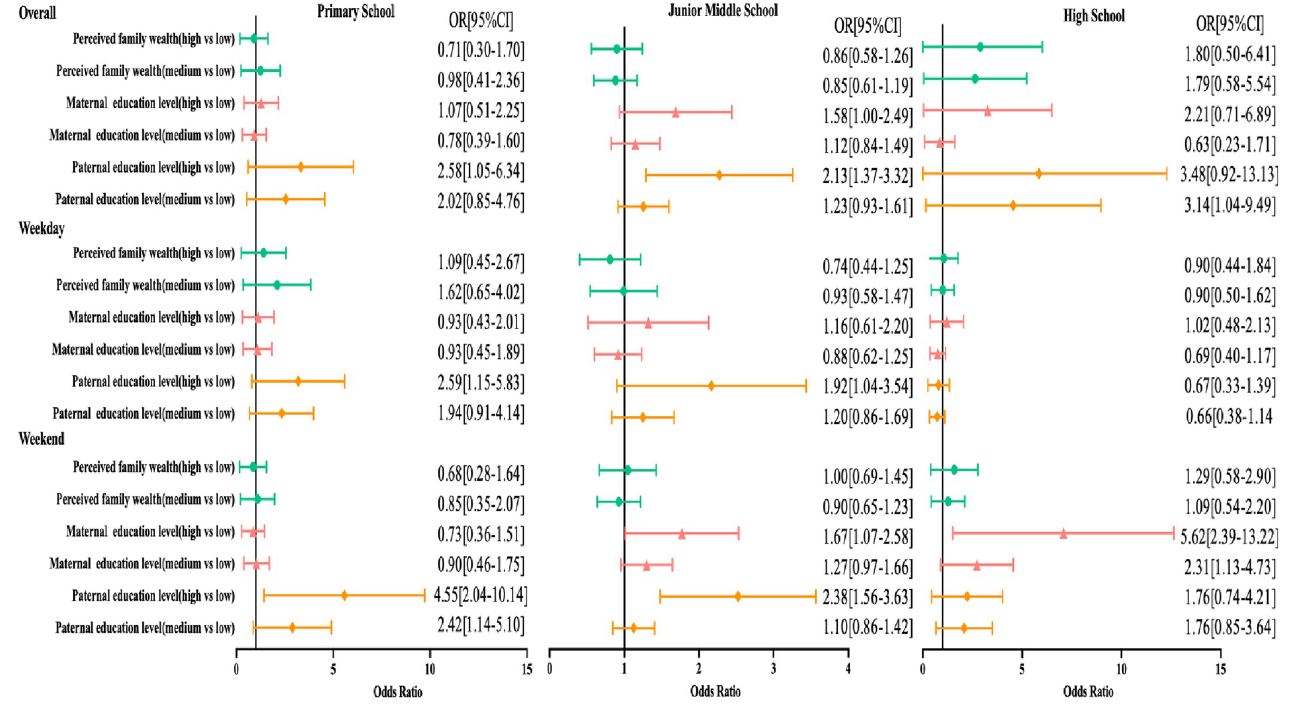
Fig 3. Regression analysis of grade differences in socioeconomic status and screen